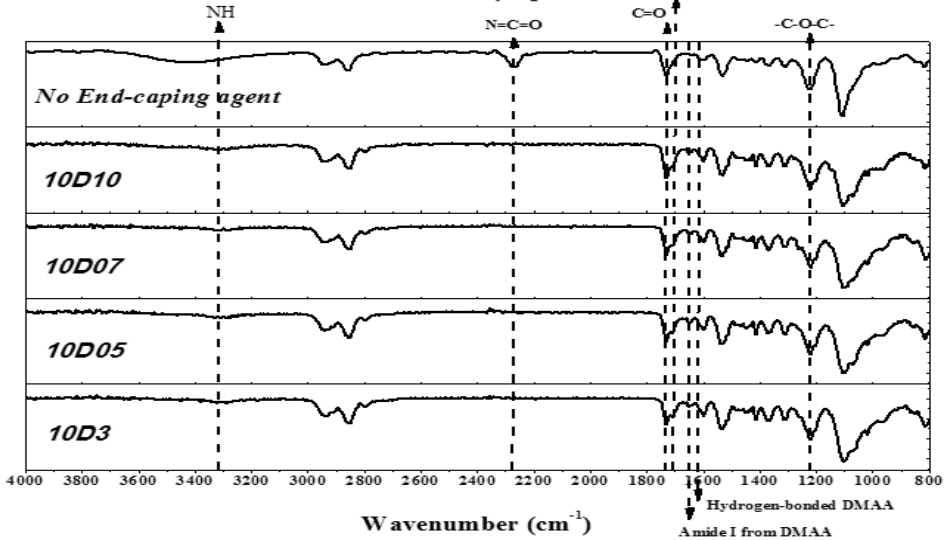
Figure 3. FT-IR spectra of TPU.